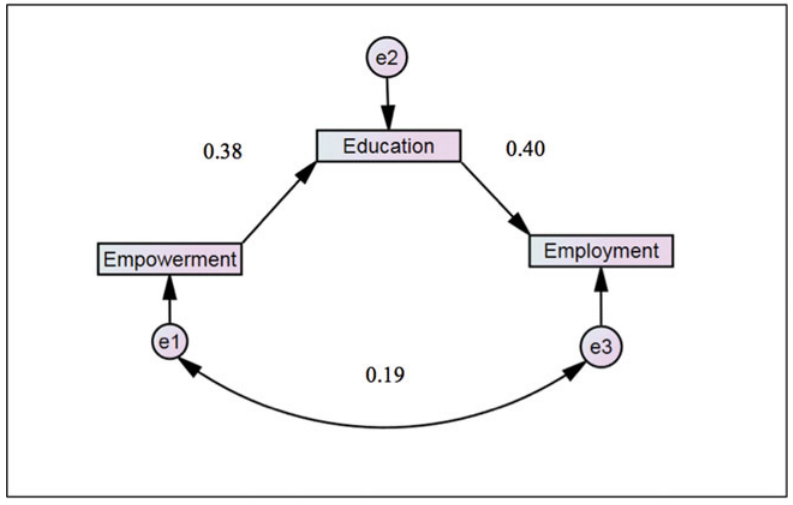
(Colour online) SEM showing bivariate correlations. χ 2 /df = 2.47, CFI = 0.99, RMSEA = 0.04, Pclose = 0.89. P < .001 e = error.